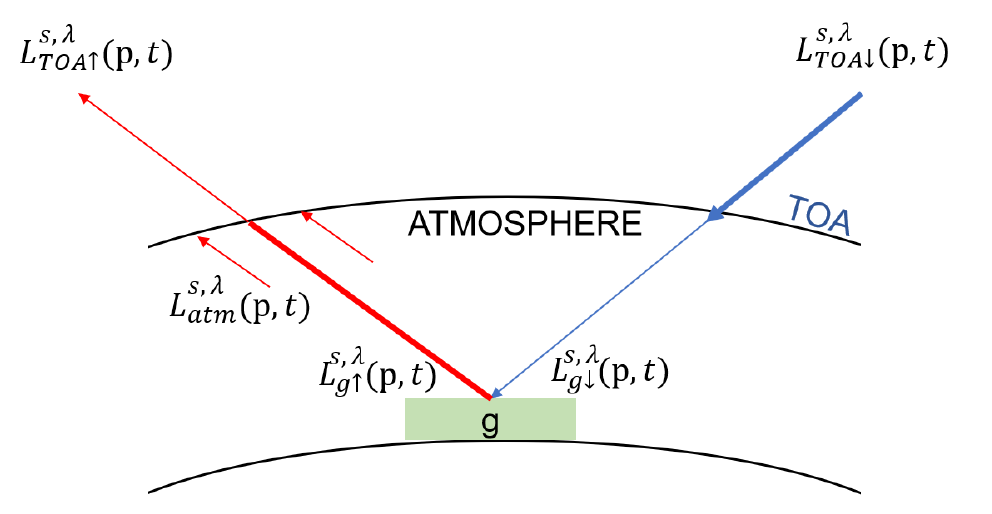
Figure 2. Simplified illustration of the interaction between the main quantities taken into account in the